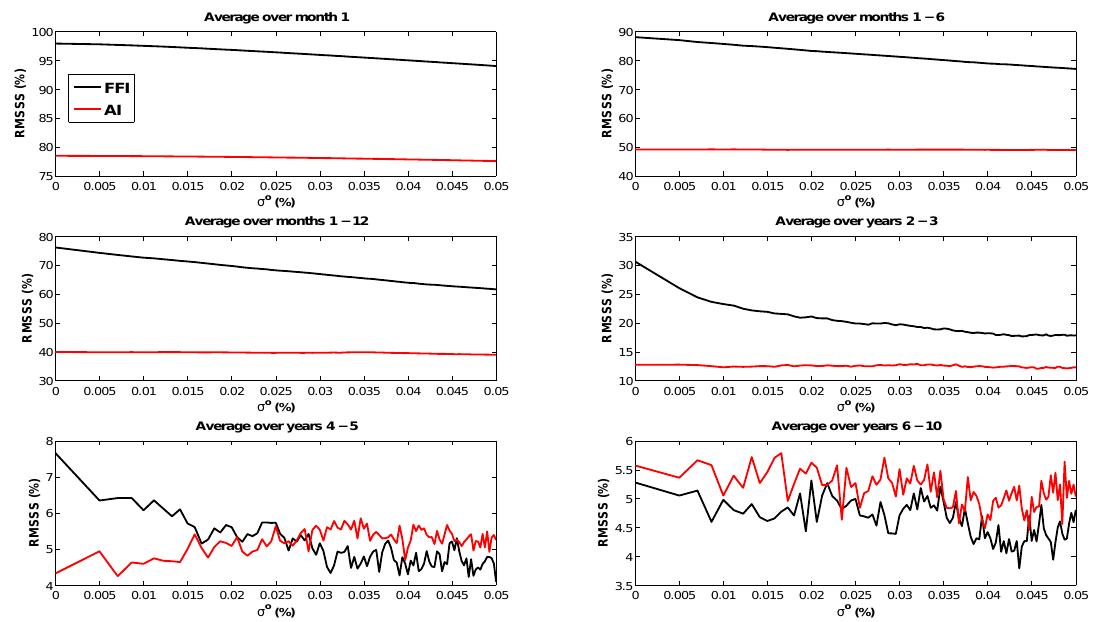
Fig. 4. RMSSS as a function of the standard deviation of the observational error, σ o , expressed as a fraction of the system’s natural variability. The six panels refer to six different averaging periods and are indicated in the corresponding labels. FFI (black line), AI (red line).